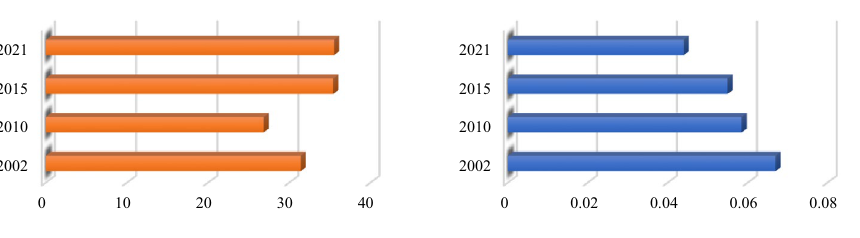
Delineation of frost-affected areas. Additionally, we used remote sensing variables (DEM, aspect, slope, LST, precipitation, and soil moisture), meteorological datasets (sunny days and cloud ratio), and the ANP method to detect and model climate change impacts on the FS based on frost-affected areas. Figure 8 shows the most frost-affected areas in the study area from 2002 to 2021. Our accuracy assessment indicates the satisfying results (> 0.92) of the remote sensing-based technique in concert with the ANP (Table 6). As shown in Fig. 9, the area and percentages of each class are further detailed. Based on Figs. 8 and 9, it can be concluded that frost- affected areas within the LUB increased between 2002 and 2021. In the south and west parts of the LUB, areas where gardens are located, are nearly covered in frost, as shown in Figs. 6 and 8. Within 19 years, the area with very high frost values increased from 25.94 to 30.79% in the study area (Fig. 4). Delineation of frost threshold for each garden product. In determining frost-affected areas, LST plays a vital role. The Zonal Statistics Table tool in the Arc GIS environment estimated frost resistance thresh- olds in Celsius degrees (°C) for apple, peach, grape, and apricot garden products. Table 7 represents the frost resistance thresholds for apple, peach, grape, and apricot, which ∗ means the exact threshold that apple, peach, grape, and apricot have. Table 7 results indicate that apple, peach, and apricot trees suffered the most damage (100%) in 2010 and 2015. In March, when all trees start to bud, most frosts occurred, according to data collected from West and East Azerbaijan Meteorological Organizations (www. eamo. ir). Meteorological data indicate that between 2010 and 2015, the minimum temperature reached − 4.5 °C, which exceeded apple, peach, and apricot resistance thresholds. A frost affected grape trees in the second rank, causing 80% to 90% damage. For example, in 2010, 87,757 ha of the LUB’s lands were cultivated with fruit trees, which was expected to yield 824,806 t of crops. According to the Agricultural Organization of West Azerbaijan Province (AOWAP) (www. waaj. ir), more than 58,760 ha of fruit orchards were damaged by frost, and the amount of production decreased to 482, 240 t. According to Table 7, frost damage in 2021 was estimated at 70% to 100%. Accordingly, peach and grape prod- ucts tolerated the most damage, with frost resistance thresholds of < − 1.3 and < − 5 °C, respectively. Apricots and apples were ranked second and third, respectively in 2021. In 2002, fewer trees were affected by frost than in 2010, 2015, and 2021. Approximately 80% to 90% of the damage was estimated this year. The frost resistance thresholds for apple, peach, and apricot trees were between − 1 and − 3 °C. From 2002 to 2021, the impacts of climate change on garden products increased. A sudden snowfall during the last decade caused frost in March